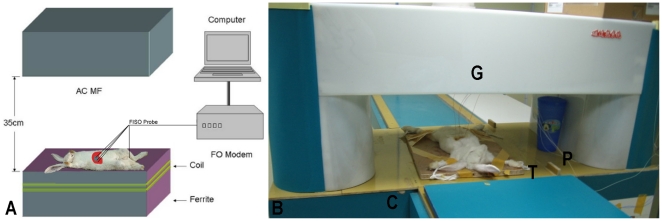
Arterial embolization hyperthermia therapy system.Figure 12A Scheme of AEH therapy system and method of temperature
measurement in vivo. Four FISO probe fibers that were
attached to the inside wall of a plastic tube connected to a computer
were used to detect temperature changes in the tumor core, tumor rim,
and 1 cm from the tumor and rectum. Figure 12B Apparatus of new arterial
embolization hyperthermia therapy system for large animals or humans.
The system comprises a generator (G), induction coil (C), treatment
table (T), and FISO probe (P).